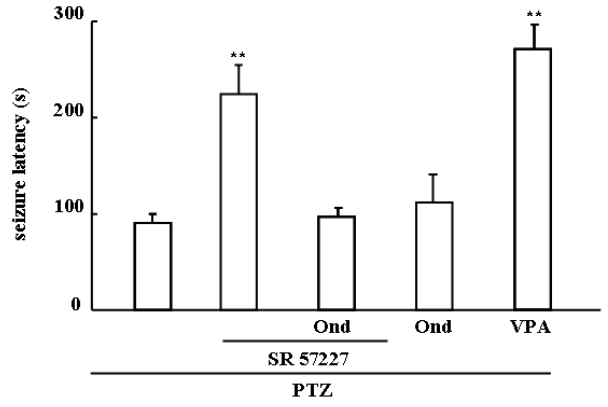
Figure 2. Effects of ondansetron on SR 57227-induced prolonged seizure latency. PTZ: pentylenetetrazole (65 mg/kg, i.p.); SR 57227: 10 mg/kg, i.p; Ond: ondansetron (0.2 mg/kg, i.p.); VPA: sodium valproate (400 mg/kg, p.o.). Columns represent the mean